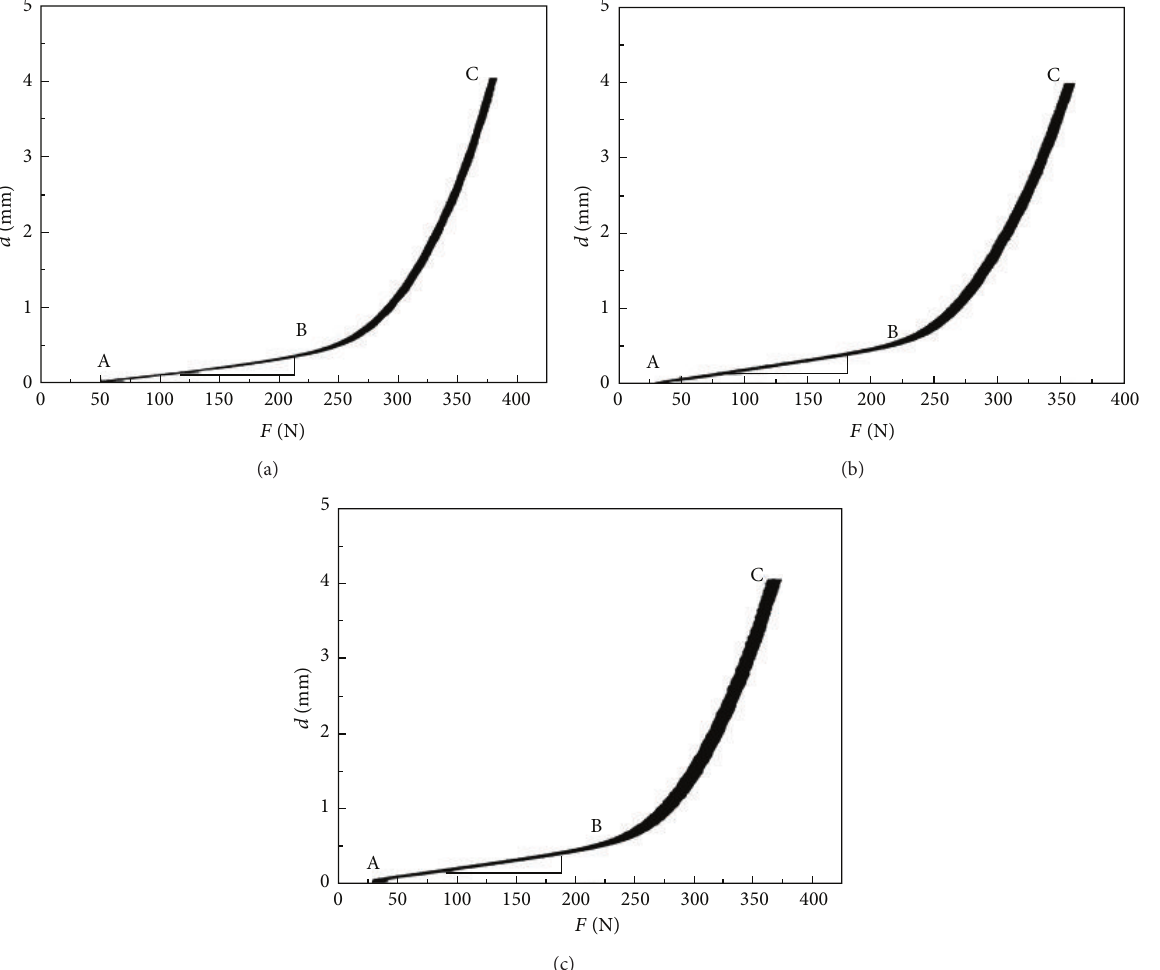
Figure 7: The relationship between the bending deflection ( 𝑑 ) and the applying load ( 𝐹 ) of the sample. (a) The 𝑑 - 𝐹 curve of sample 1; (b) the 𝑑 - 𝐹 curve of sample 2; (c) the 𝑑 - 𝐹 curve of sample 3.